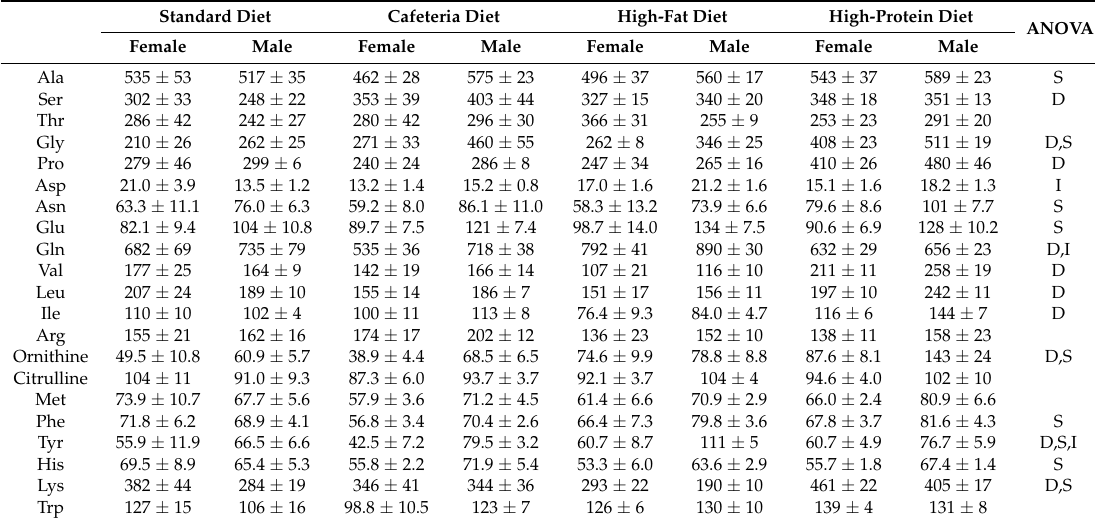
Note: The data ( µ M) correspond to the mean ± SEM of 6–8 different animals. Statistical analysis was two-way ANOVA: p -values are for diet (D), sex (S), or interaction (I).